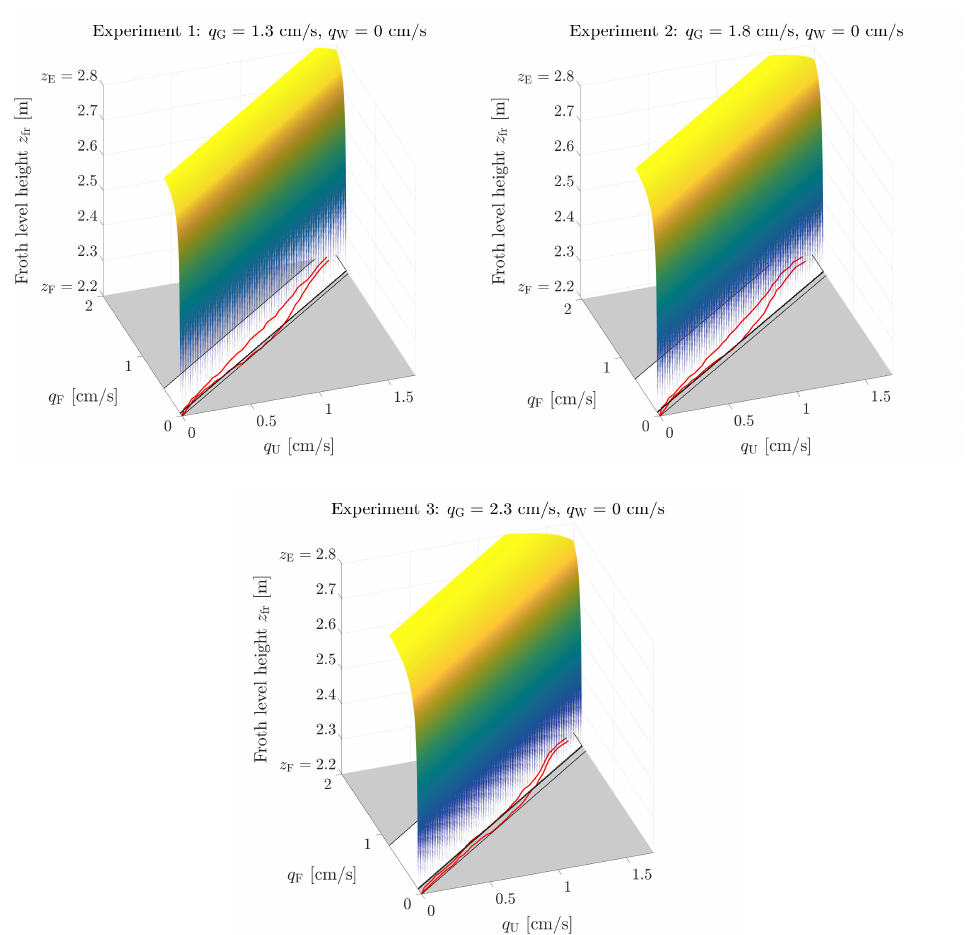
Figure 9. Experiments 1–3 (no wash water): Comparisons between the model with stationary conditions. Here, and in Figure 10, each ( q U , q F ) -plane shows the operating chart in which the white region shows the theoretical conditions for a pulp–froth level above the feed level z = z F (cf. Figure 8). The red lines in that plane (see also Figures 3 and 4) show the experimental lower and upper values of q F for each given q U , in between which, a pulp–froth level was observed. The yellow surface is the Z fr ( φ F , q G , q F , q U , q W ) , i.e., the estimated height of the pulp–froth graph of the function ( q U , q F ) (cid:55)→ interface by the model.